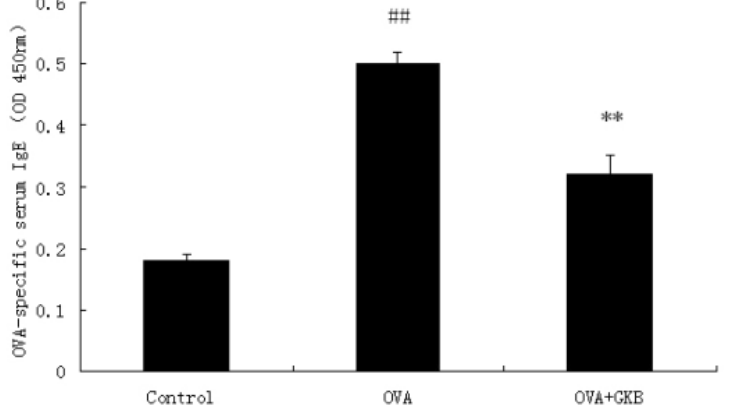
Figure 2. Effects of ginkgolide B on OVA-specific IgE in serum. OVA-specific IgE levels in the serum were measured by ELISA. Results (means ± SEM) are expressed as Optical Density values and are representative of at least three independent experiments, GKB = ginkgolide-B (## p < 0.01 vs. control group mice, ** p ＜ 0.01 vs. OVA-challenged mice).